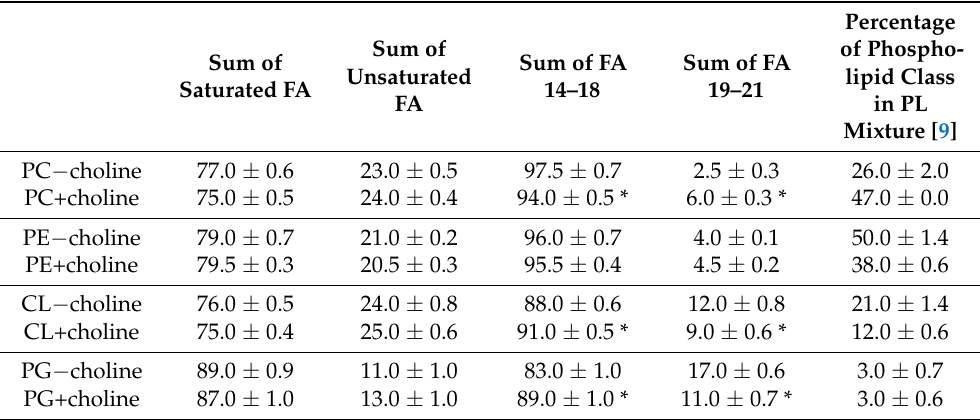
Figure 1. Relative content (%) of fatty acids in the PL classes isolated from the bacteria cultured on the medium without and with choline. a , methyl branch at the anteiso carbon atom; i , methyl branch at the iso carbon atom; n , unbranched acid; c , cyclopropane ring structure; ± standard deviation; * indicates a significant difference in the MW test for choline vs. the lack of choline comparison in each PL. The test was carried out for fatty acids with at least 5% relative content. Table 2. Fatty acid (FA) composition (relative content, %) of individual phospholipids (this study). The percentage of individual classes in the phospholipid mixture isolated from L. gormanii cultured on the medium without and with choline (previous study [9]); * indicates a significant difference in the MW test for choline vs. the lack of choline comparison in each PL.